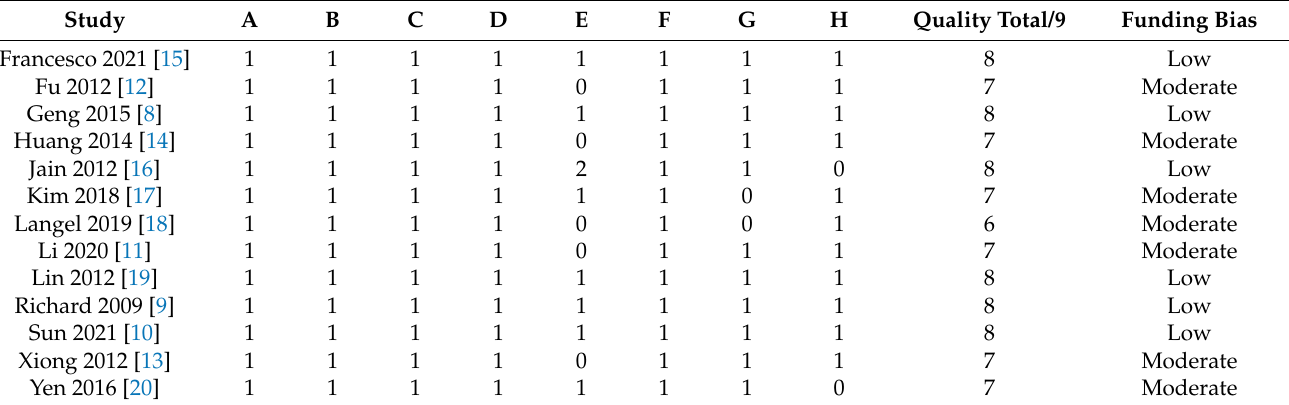
Table 4. Quality of the 13 included studies that provided the original data of CTP parameters.